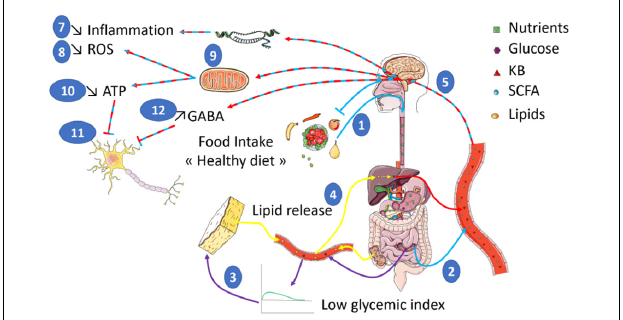
FIGURE 1 | Food intake of a diet rich in low glycemic index food is shown to have a positive impact on health (1). The composition of such a diet enriched in non-digestible fibers leads to the production of SCFA (Short Chain Fatty Acids) by gut bacteria (2). In addition, the low impact on glycemia (3) will trigger an increase in KB (Ketone Bodies) production through the induced lipid oxidation increase (4). In turn, both ketone bodies and SCFA are expected to act on brain function (5) by stimulating the transcription of genes (6) involved in the reduction of inflammation (7) and ROS production (8). SCFA and KB also modulate mitochondrial activity (9) to reduce ROS production. In addition, the reduced mitochondrial respiration will diminish ATP levels (10) that would inhibit neuronal activity (11). Finally, other studies indicate increased GABA levels also contribute to the inhibition of neuronal activity (12). Altogether, such a global effect on brain bioenergetics could participate to brain benefits of healthy diet in the context of brain disorders whose neuronal function is